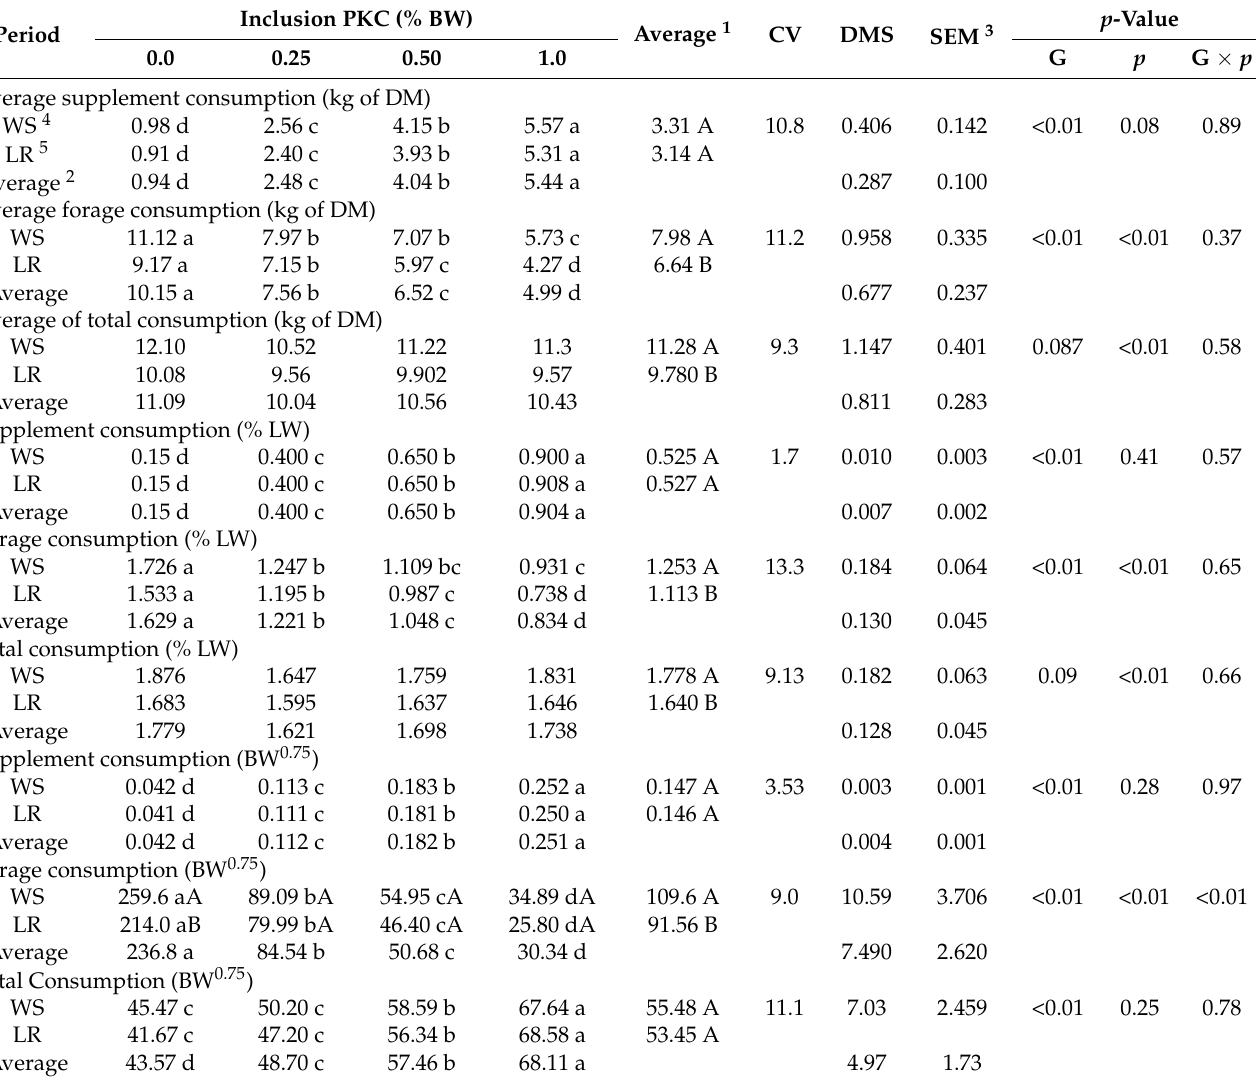
Table 3. Supplement, Marandu forage, and total feed intake by buffaloes in two seasons in the eastern